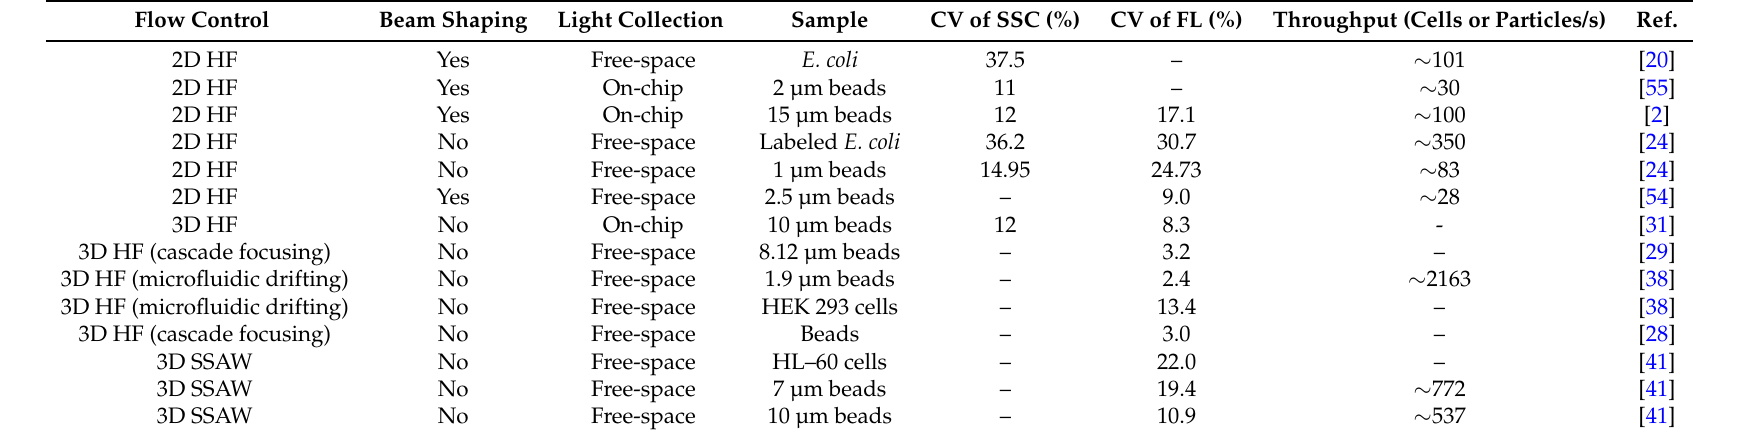
Table 3. Performance of recently developed optofluidic microflow